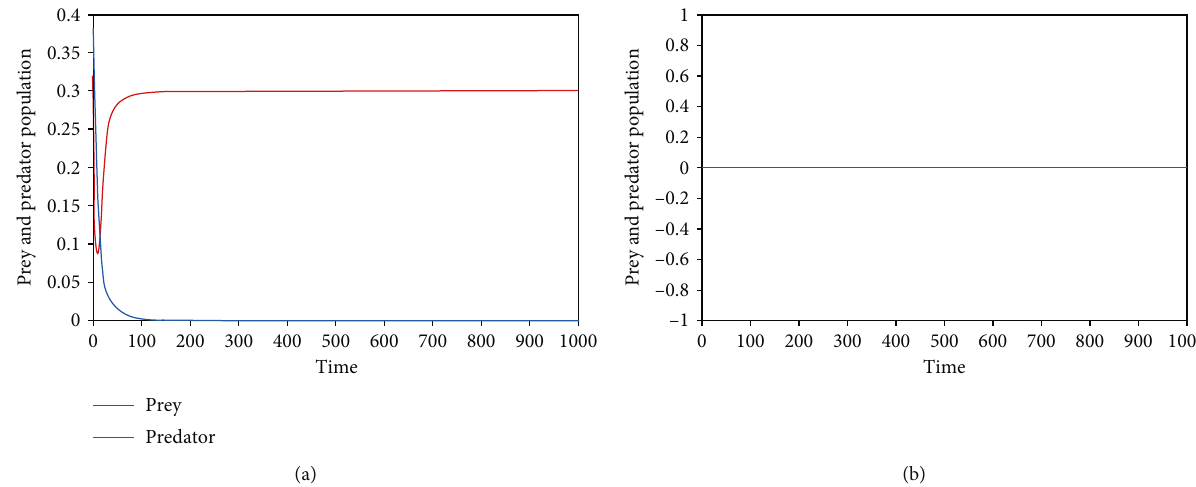
1 with parametric value as in